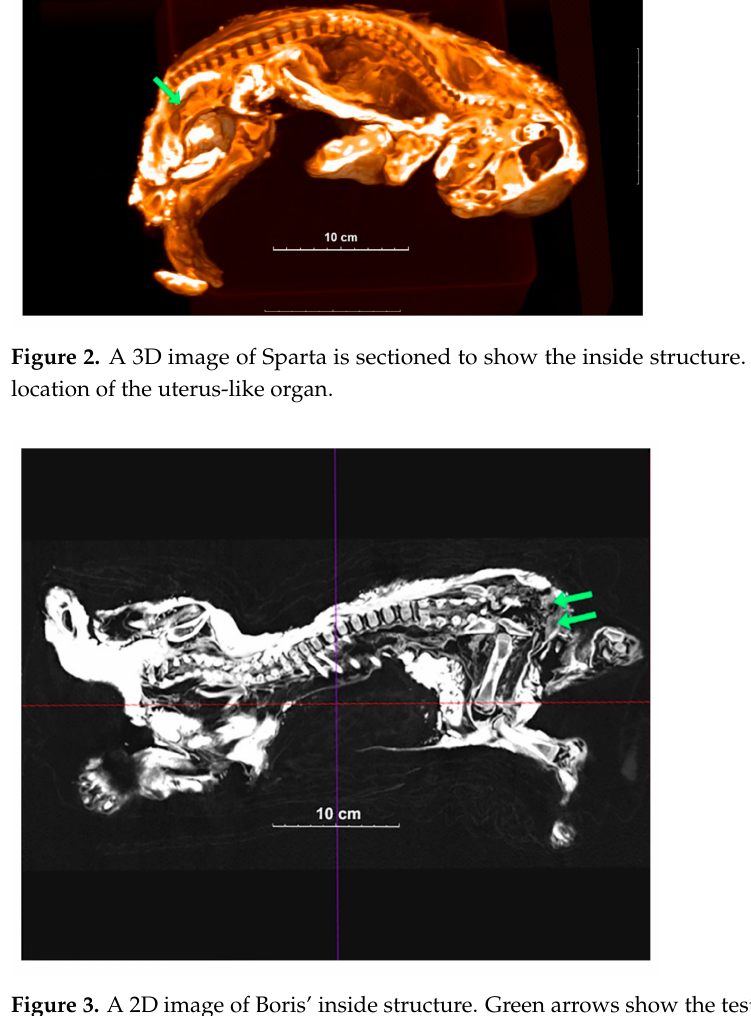
Figure 3. A 2D image of Boris’ inside structure. Green arrows show the testicle-like organs.